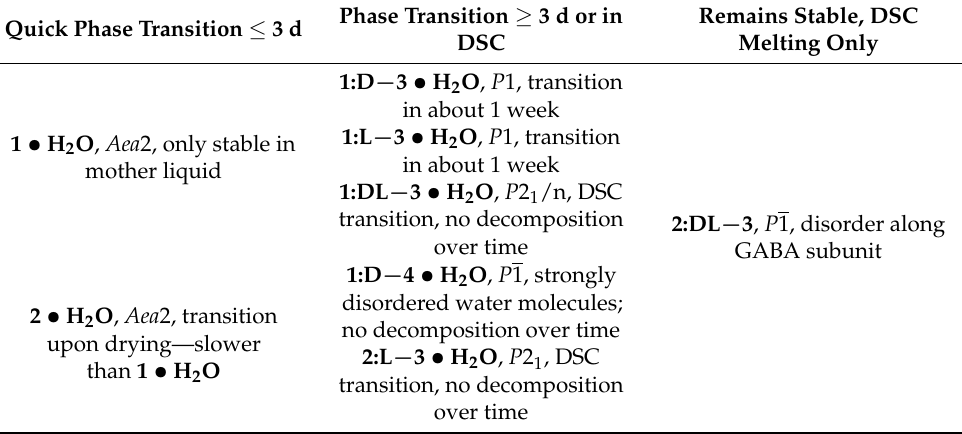
Table 2. Overview of the received single crystalline forms. The depicted compounds containing Baclofen ( 1 ), Phenibut ( 2 ), tartaric acid ( 3 ) or malic acid ( 4 ) are sorted by their tendency to transit phases. Products in the left column remain stable only until dried. Products in the mid column remain stable for a longer time upon drying or show transition signals other than melting in the DSC. The product in the right column remains stable after six months under dry conditions and only shows a melting signal in the DSC. Additionally, space group information is given, and some important properties are